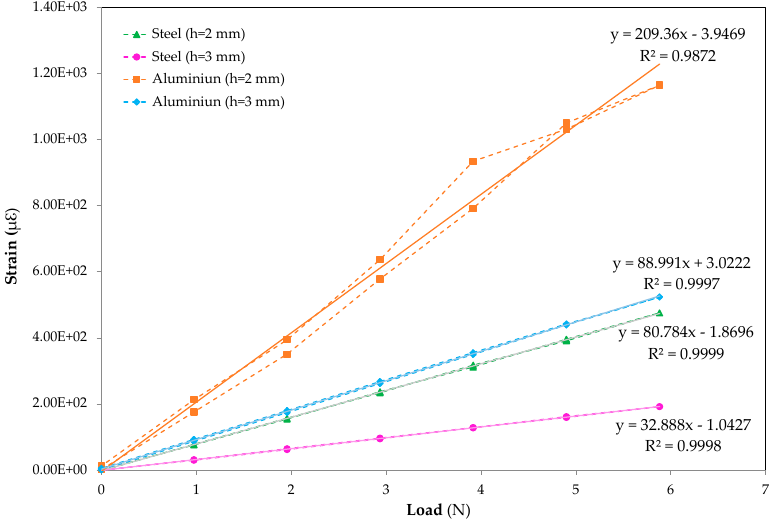
Figure 10. Deformation increment in micro-strains versus applied loads: (cid:78) steel h = 2 mm, • steel h = 3mm, (cid:4) aluminium h = 2 mm and (cid:95) aluminium h = 3 mm smart structures.